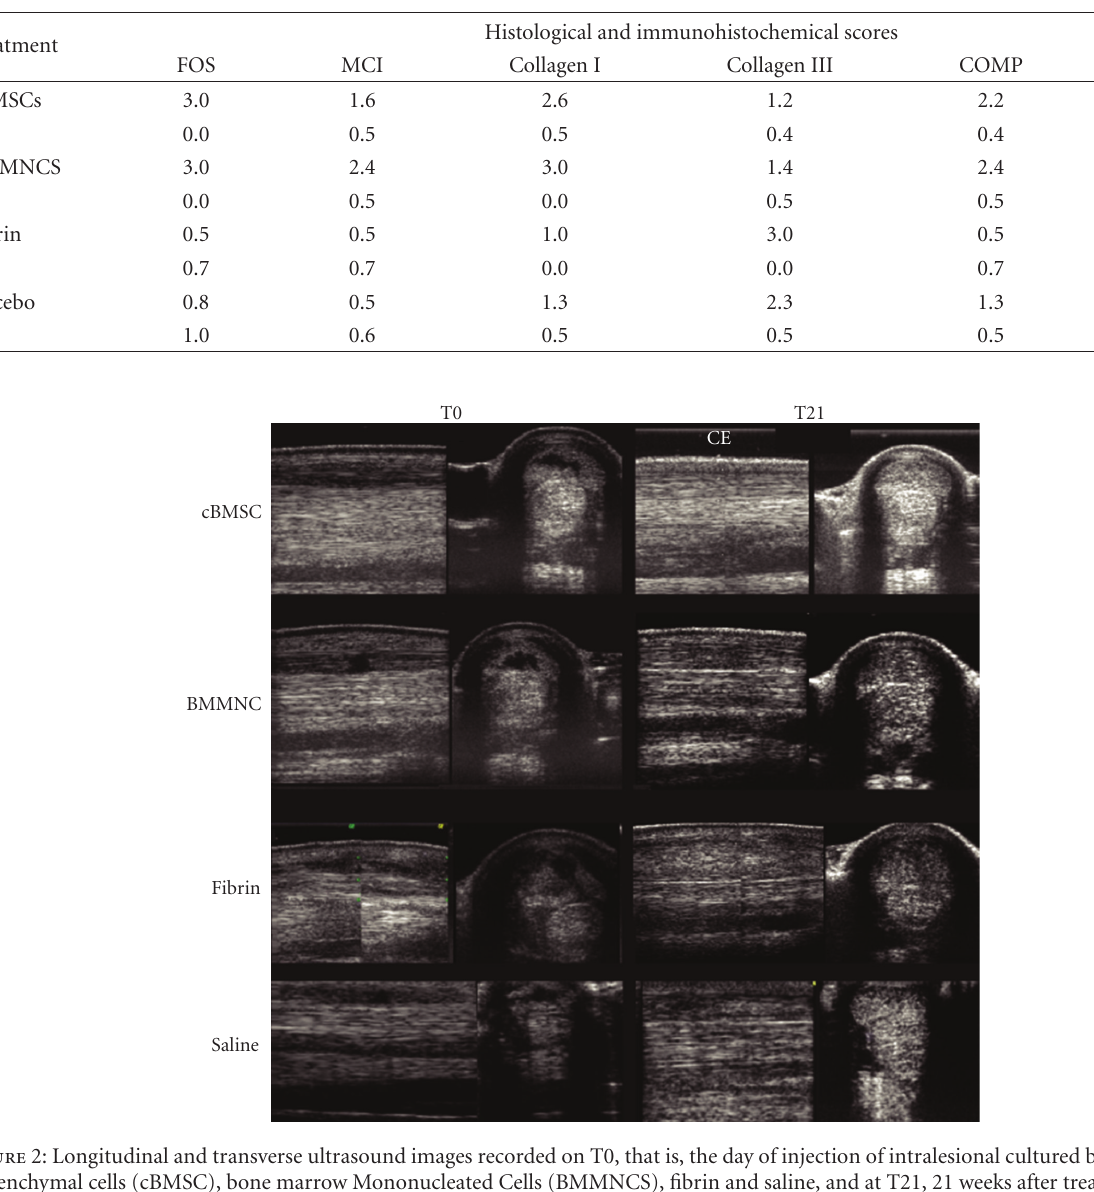
Table 1: Morphological and immunohistochemical scores evaluated for each horse at 21 weeks following treatment of collagenase-induced tendinitis SDFT, superficial digital flexor tendon; RH, right hind limb; LF, left fore limb; RF, right fore limb; cBMSCs, cultured bone marrow mesenchymal cells; BMMNCS, bone marrow mononucleated cells; FOS, fiber orientation score; MCI, mononucleated cell infiltration score; Collagen I, type I collagen fiber expression score; Collagen III, type III collagen fiber expression score; COMP, cartilage oligomeric matrix